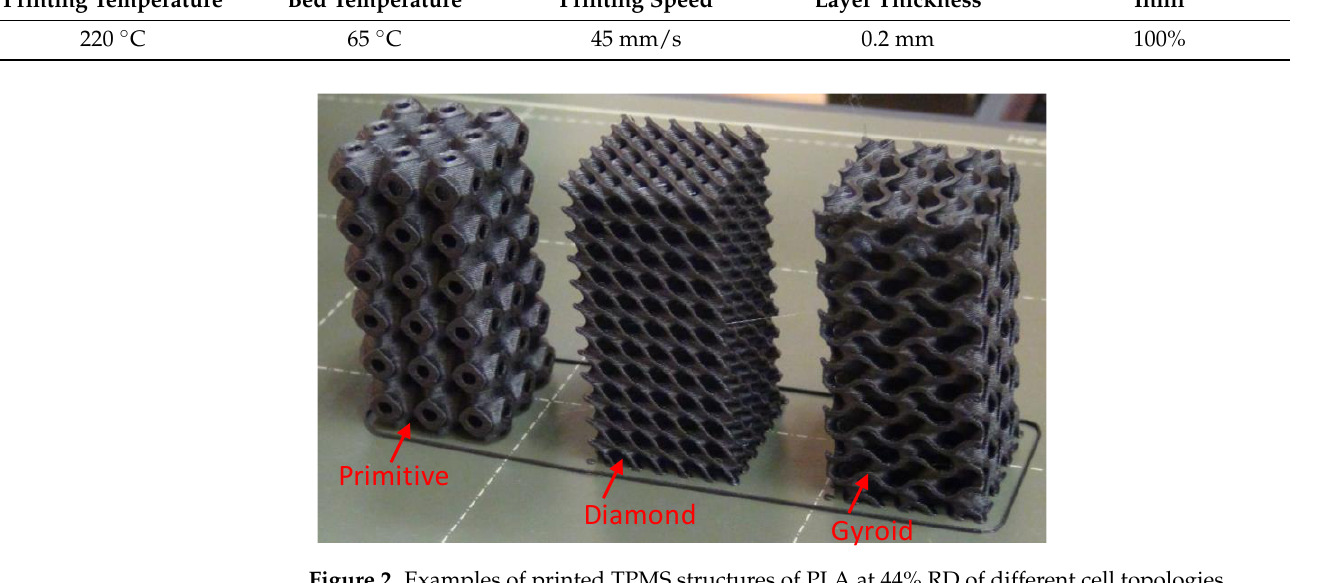
Figure 2. Examples of printed TPMS structures of PLA at 44% RD of different cell topologies.